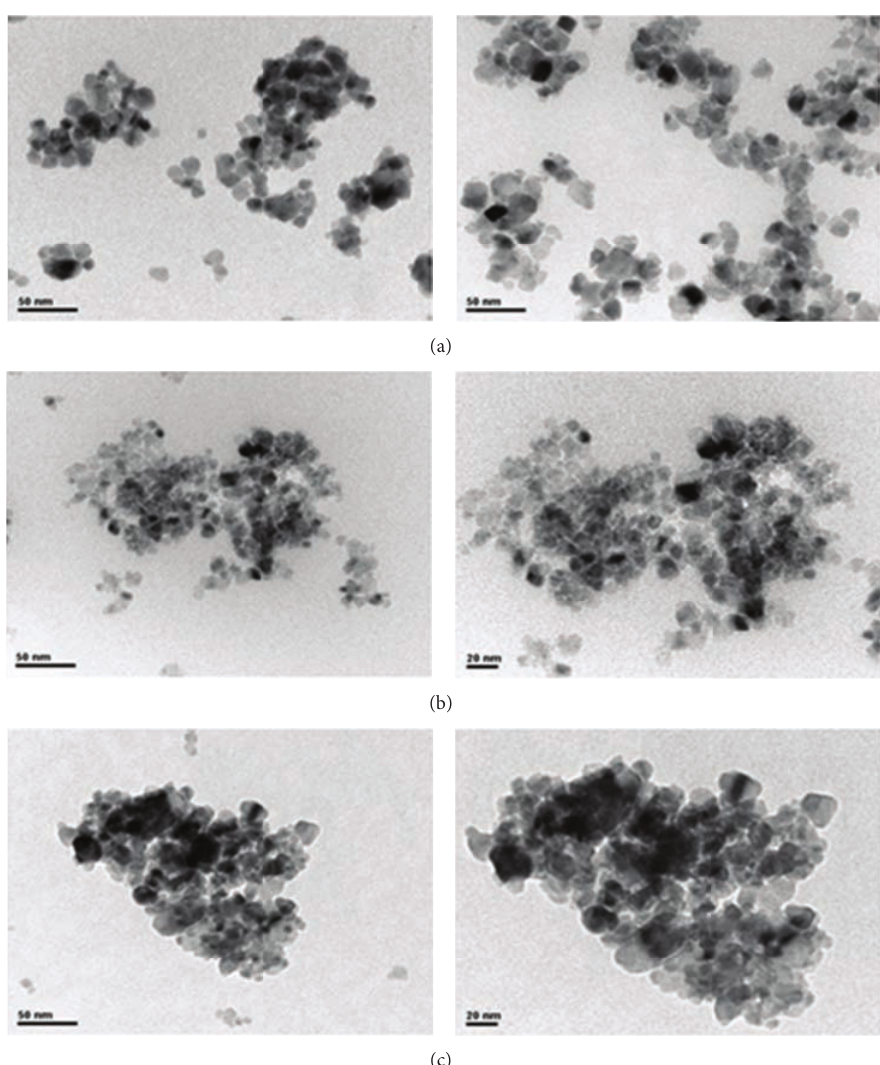
Figure 7: TEM images of synthesized TiO 2 nanoparticles: (a) 0% AC, (b) 5% AC, and (c) 10% AC.